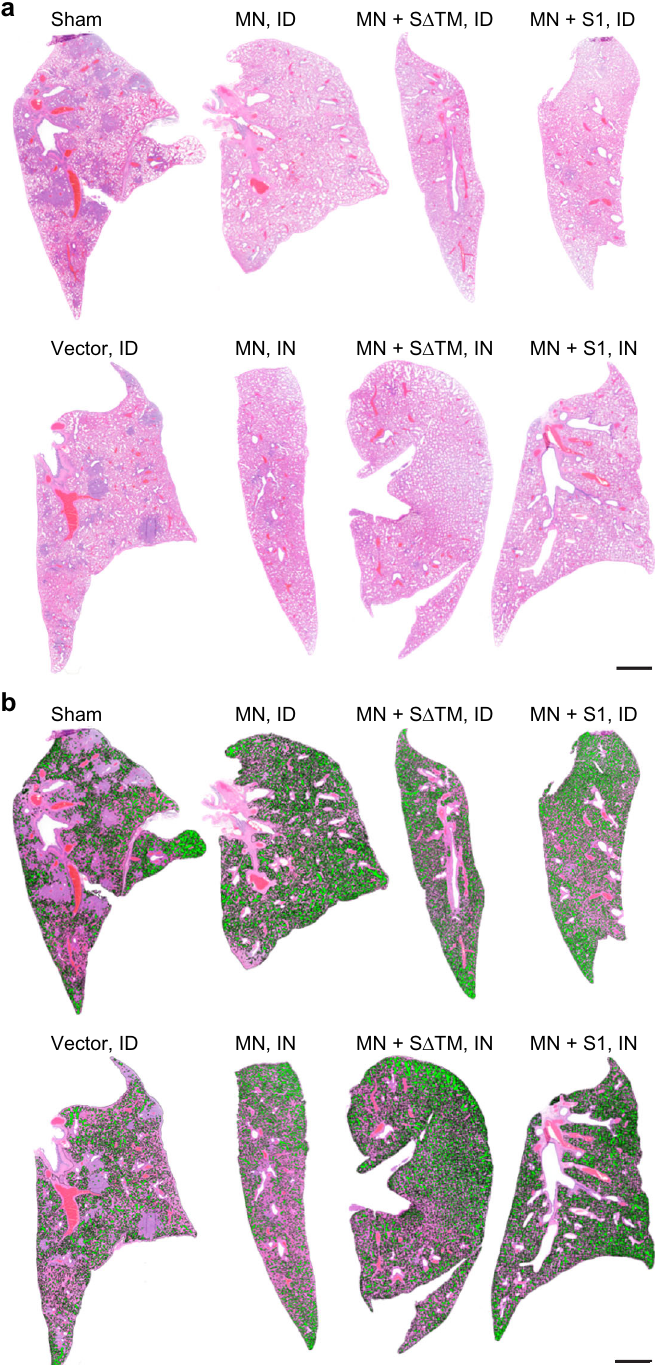
Fig. 4 Impact of MN vaccines on histopathology and percent alveolar air space. The selected images were obtained from a lung of a hamster scoring near the mean histopathological score of its immunization group, as indicated. a Histopathology (H&E stained lung sections). b Percent alveolar air space. The percent alveolar air space for each lung shown is as follows: Sham, 23.6%; MN vaccine administered intradermally [MN (ID)], 33.4%; MN + S Δ TM (ID), 31.6%; MN + S1 (ID), 31.2%; LVS Δ capB vector [Vector (ID)], 20.8%; MN vaccine administered intranasally [MN (IN)], 25.5%; MN + S Δ TM (IN), 31.4%; and MN + S1 (IN), 35%. Scale bars = 2 challenge, respectively ( P = 0.04, 0.02, and 0.004, resp.); hamsters assay. Hamsters immunized ID or IN with MN alone, or in immunized ID with MN + S Δ TM or MN + S1 also showed combination with S Δ TM or S1, showed signi fi cantly reduced viral signi fi cant reductions in viral titer compared with sham- titers in the oropharynx. Speci fi cally, compared with sham- immunized animals on Day 1 ( P < 0.05 for both vaccines) and, immunized animals, hamsters immunized ID with MN showed a for MN + S1, on Day 3 ( P < 0.01) post challenge (Fig. 6a, left graph). 0.8 ± 0.4, 1.0 ± 0.4, and 1.2 + 0.4 log 10 PFU (Plaque Forming Units) Animals immunized IN with MN vaccines (MN, MN + S Δ TM, reduction (mean ± SE) in viral load at Days 1, 2, and 3 post